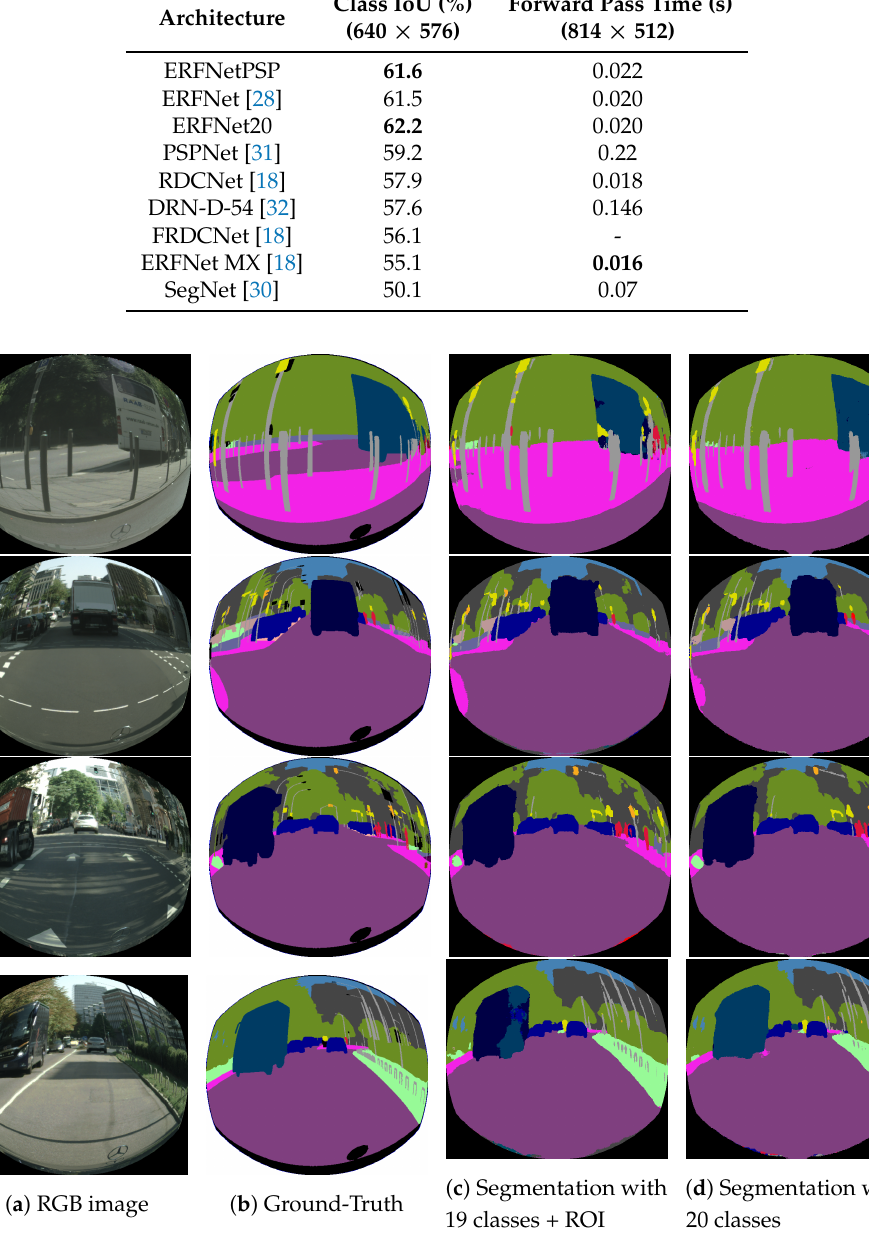
Figure 7. Comparison between different training